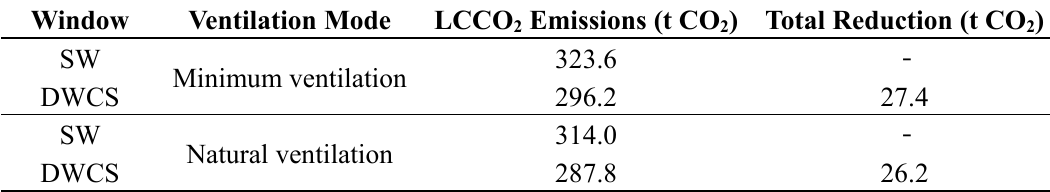
Table 15. Calculated LCCO 2 reduction